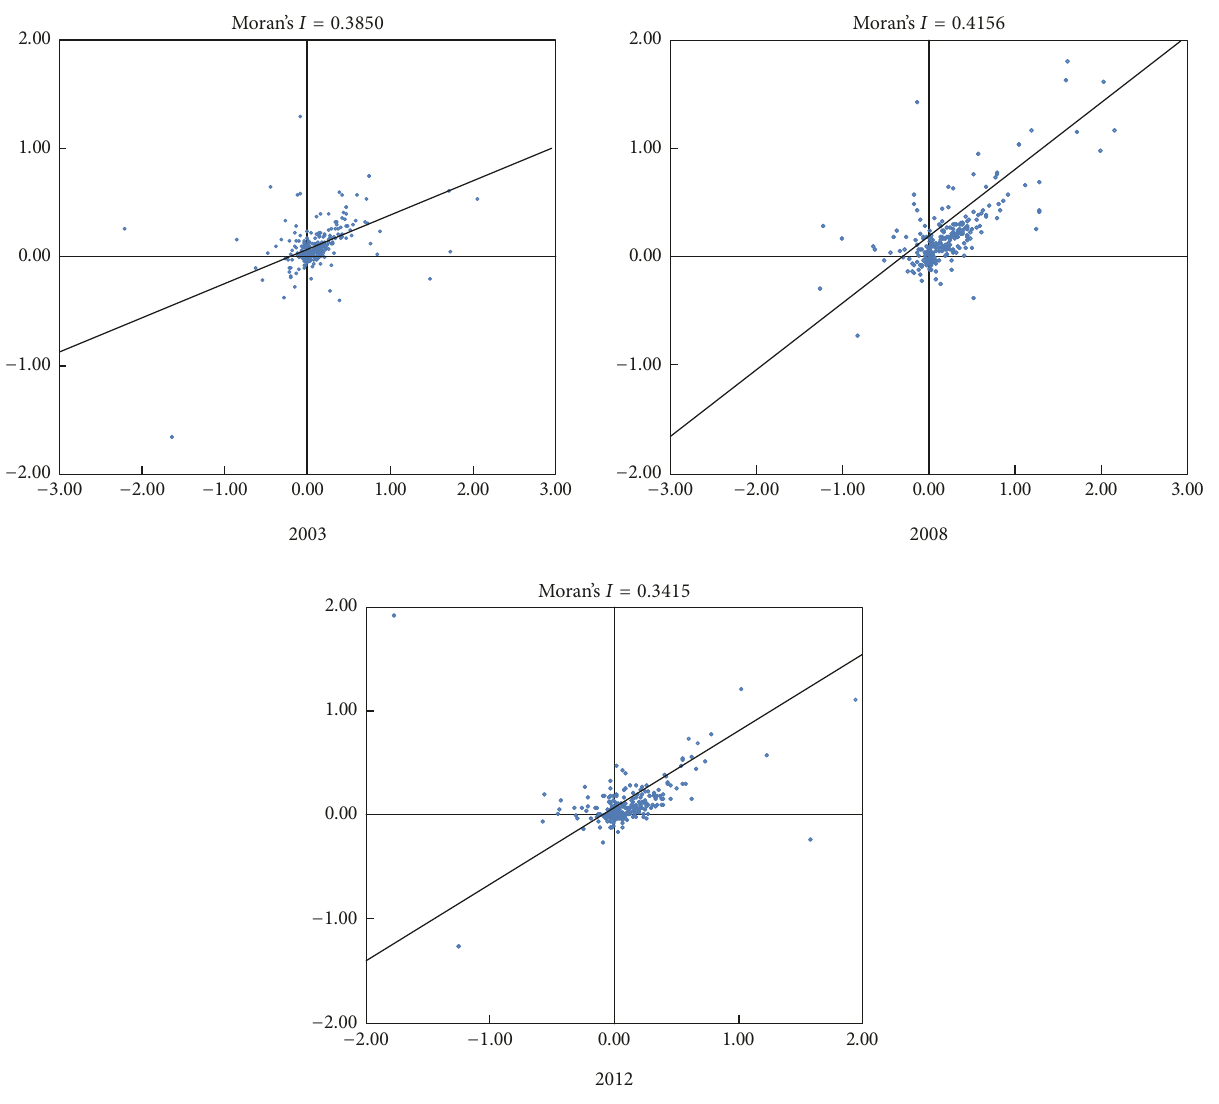
Figure 2: Moran’s I scatter plot for environmental pollution